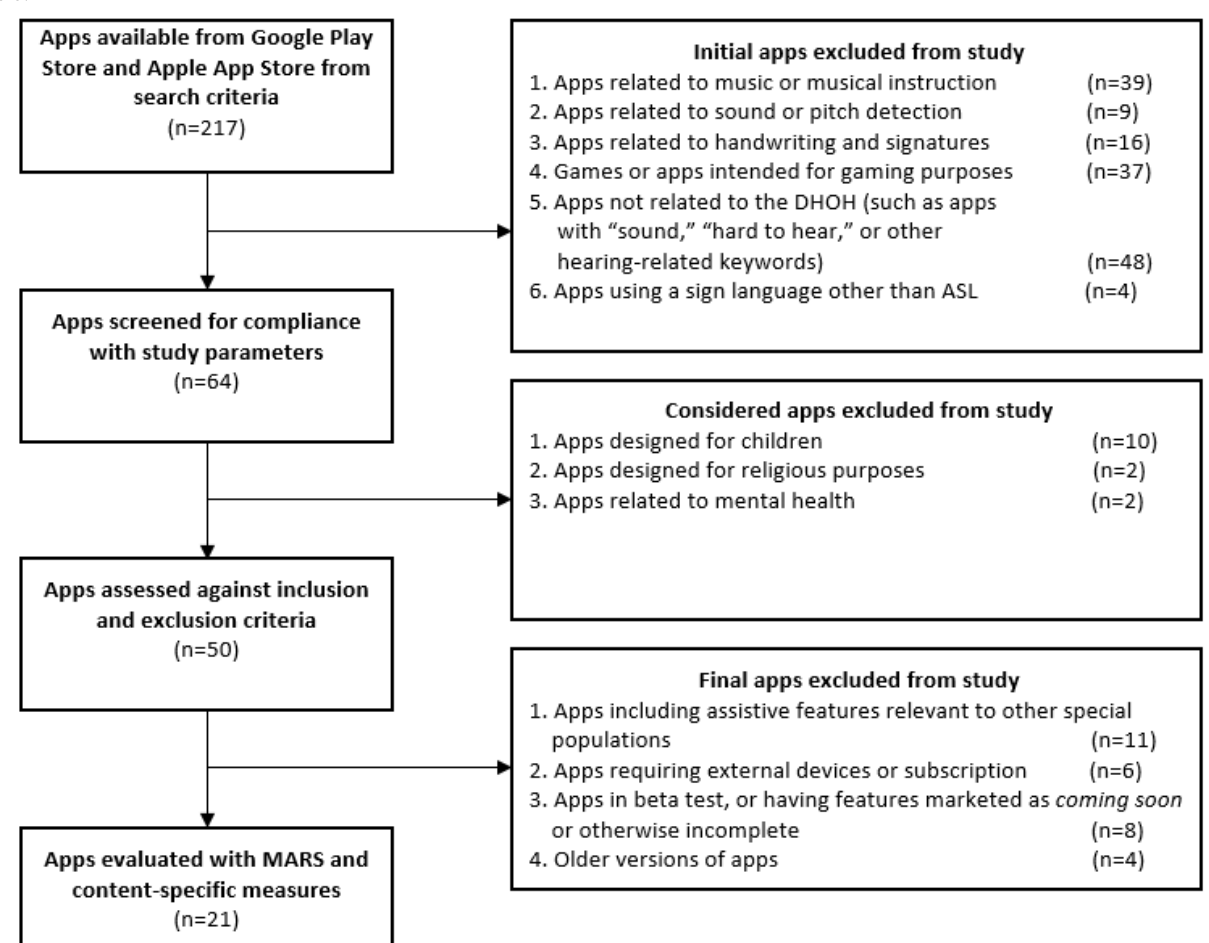
Figure 1. Inclusion and exclusion criteria flowchart. ASL: American Sign Language; DHOH: deaf and hard-of-hearing; MARS: Mobile App Rating